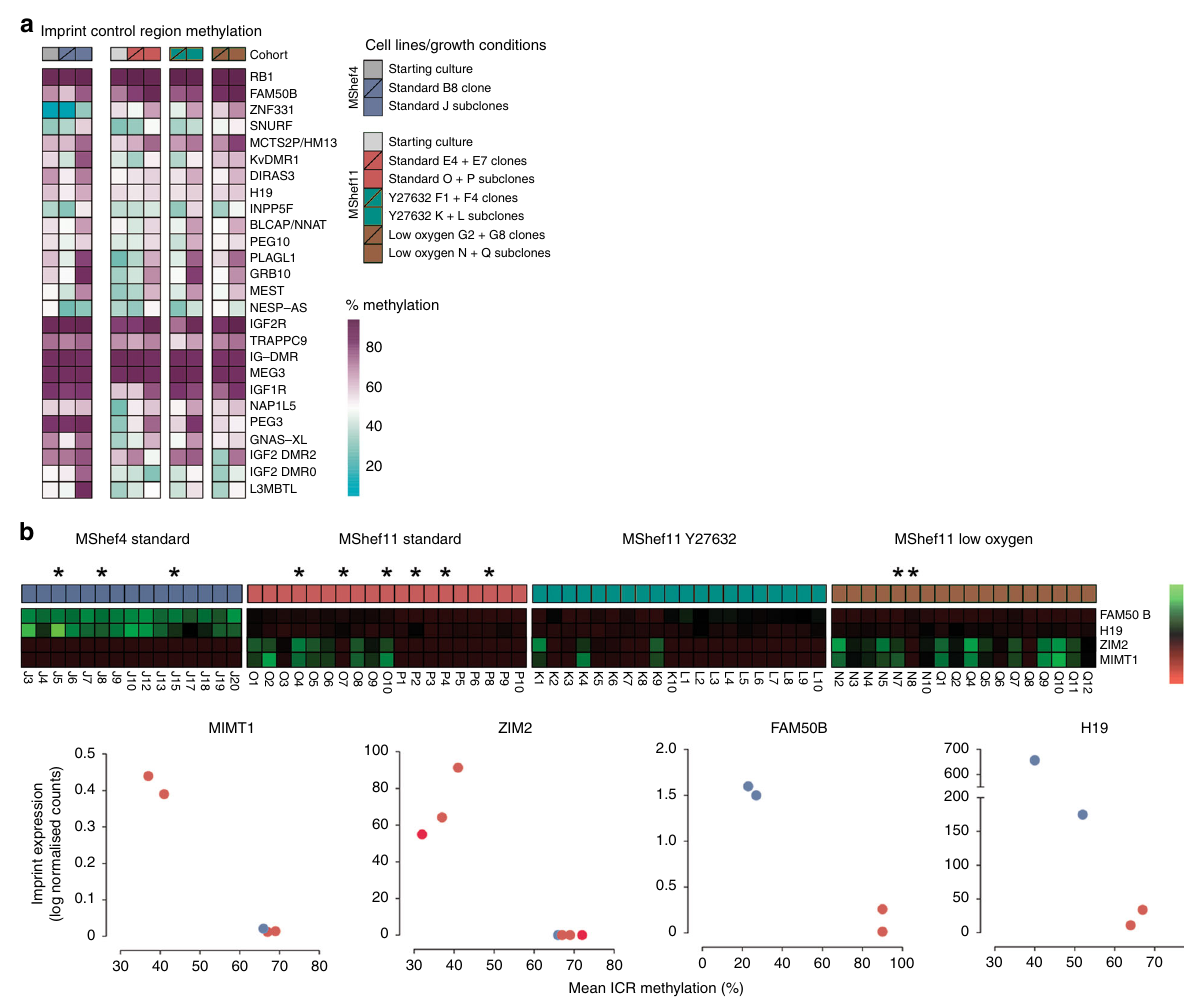
Fig. 7 Imprint methylation and expression. a Heatmap showing the methylation levels of 26 imprint control regions (ICRs) in starting cultures, parental clones, and subclones, grouped by cell line and growth-condition. Individual ICRs show a wide range of methylation levels with some notable inter- and intra-group variation. Source data are provided in Supplementary Data 14. b Top panel; heatmap showing the relative expression of four selected imprinted genes: FAM50B, H19, ZIM2 , and MIMT1 in MShef4 and MShef11 subclones. Both FAM50B and H19 are more highly expressed in MShef4 subclones; ZIM2 and MIMT1 are more variable in their expression. Lower panel; dot plots showing the correlation between ICR methylation and the expression of four imprinted genes, in a subset of MShef4 and MShef11 subclones with WGBS data of suf fi cient depth to permit such analysis (selected subclones indicated by asterisks in top panel). In all cases differences in gene expression correlate with a change in ICR methylation. Source data are provided in Supplementary Data